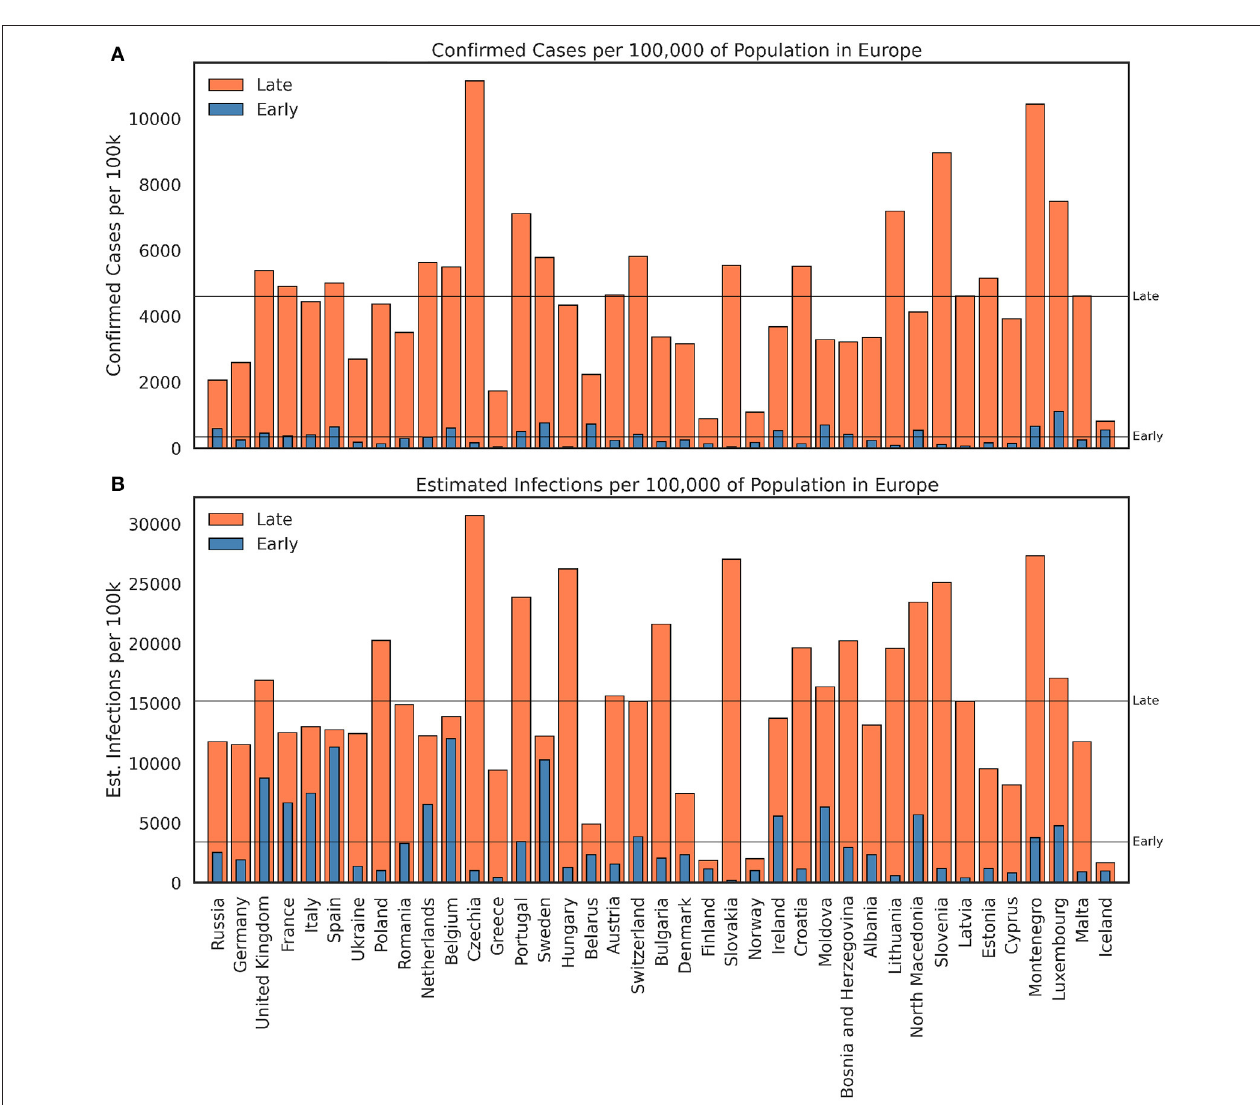
FIGURE 3 | The total number of (A) confirmed cases and (B) estimated infections, per 100,000 of population, during the early period (March–September 2020) and the late period (October 2020 - February 2021) for 39 European